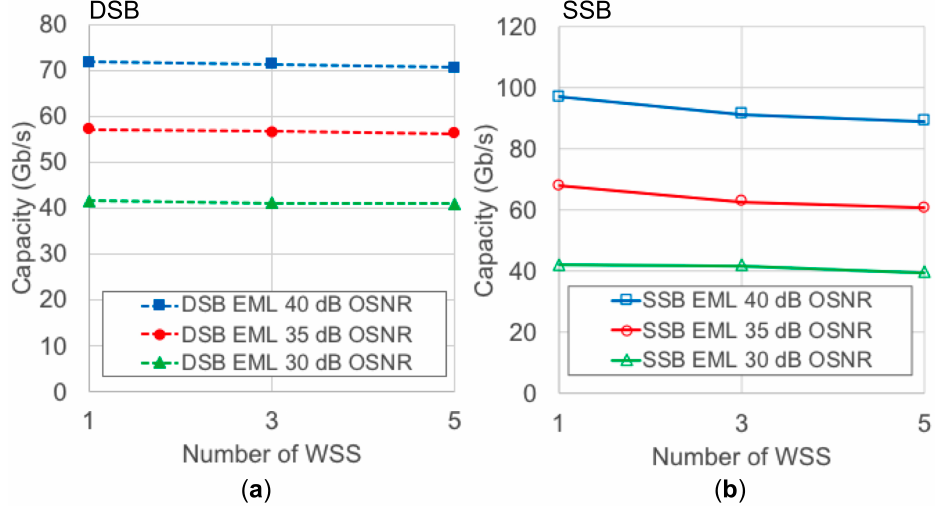
Figure 7. Transmission capacities vs number of crossed WSS for EML: 40-dB OSNR (blue square), 35-dB OSNR (red circle), 30-dB OSNR (green triangle). ( a ) DSB DMT modulation. ( b ) SSB DMT modulation.